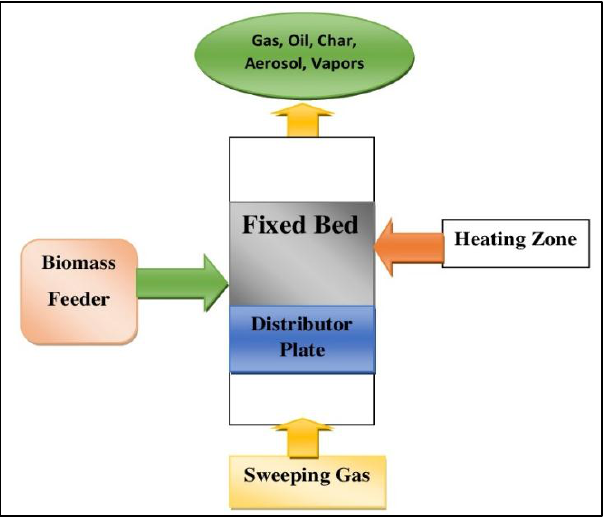
Figure 6. Fixed bed reactor.